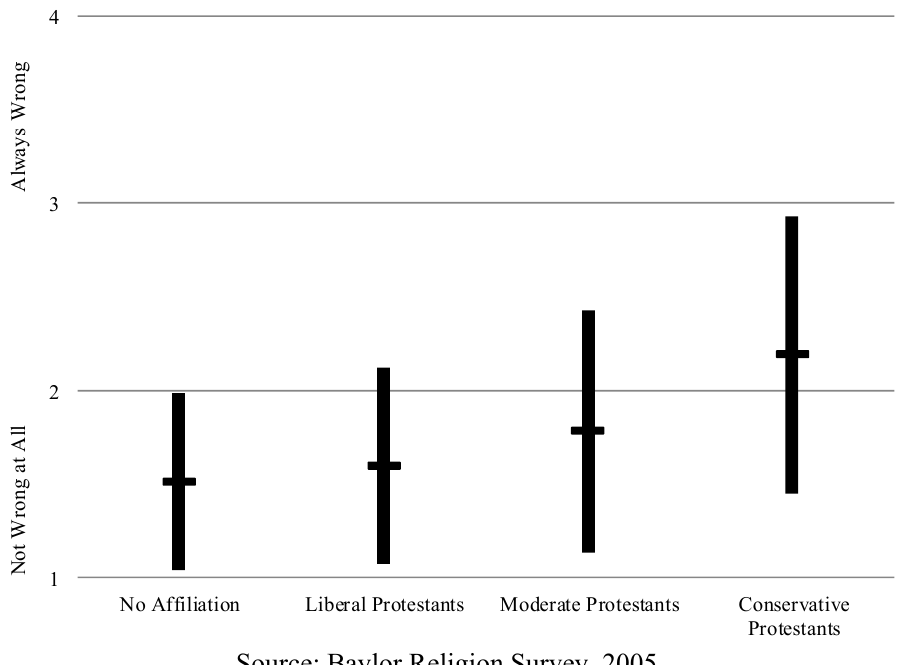
Figure 2. Individual Views on the Consumption of Alcohol (Means of responses ± 0.75 standard deviation). All differences are significant at the 0.05 level except No Affiliation— Liberal Protestants and Liberal Protestants—Moderate Protestants .